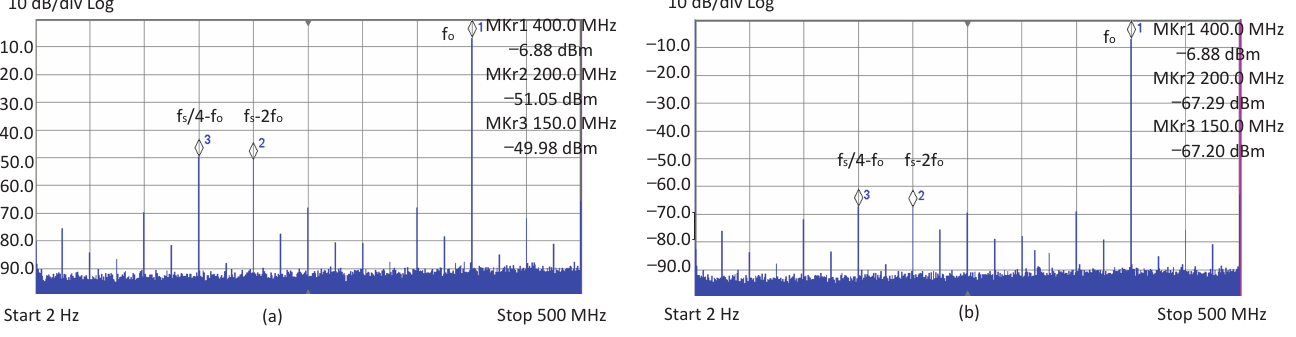
Figure 10. The spectrum of 400 MHz output: ( a ) Spectrum of before spurs reduction, ( b ) Spectrum of after spurs reduction.